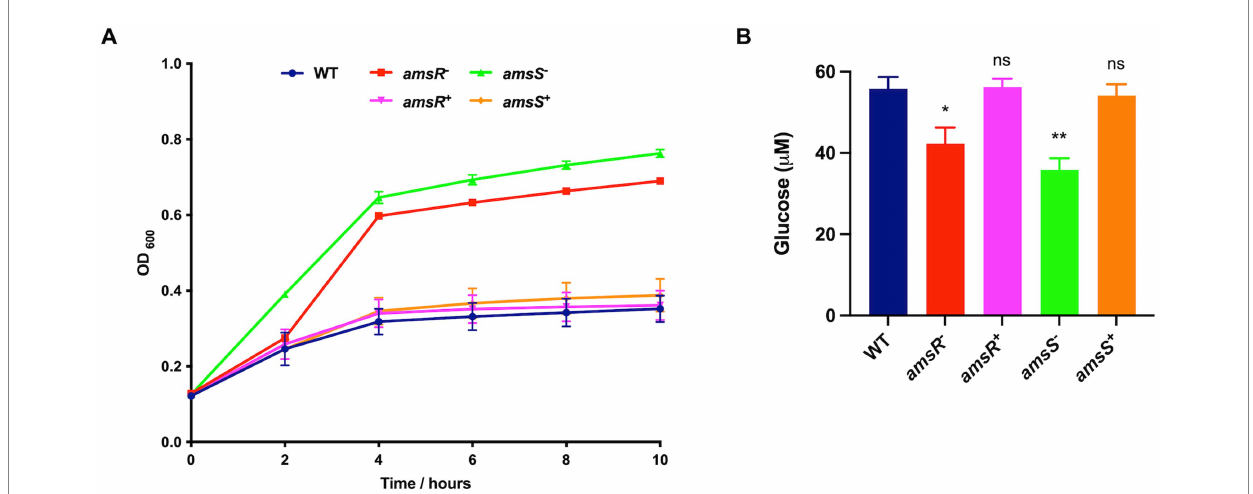
FIGURE 6 Enhanced glucose uptake in the amsR and amsS mutant strains results in accelerated growth and intracellular glucose accumulation. (A) Growth of strains in M9 media supplemented with 11 mM glucose. (B) Extracellular glucose concentrations were measured from exponentially growing cells in LB supplemented with 11 mM glucose. Data is derived from three independent biological replicates. Error bars ± SEM. One-way analysis of variance, with Dunnett’s multiple-comparisons test, was used to assess statistical significance in comparison to wild-type, * p < 0.05; ** p < 0.01; ns, not significant.